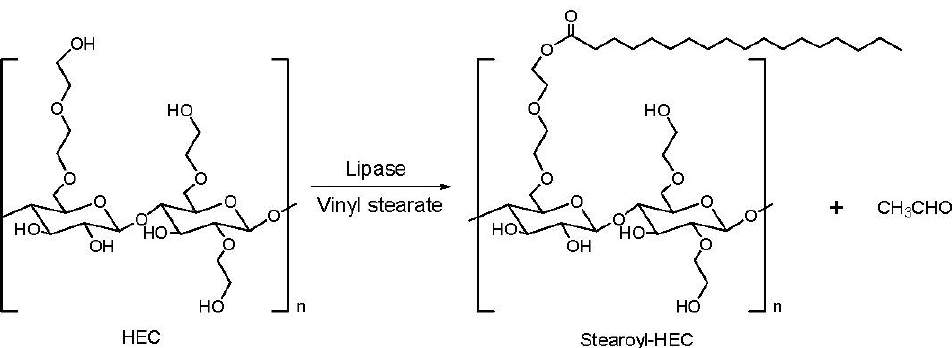
Figure 5. Hydrophobic modification of HEC.